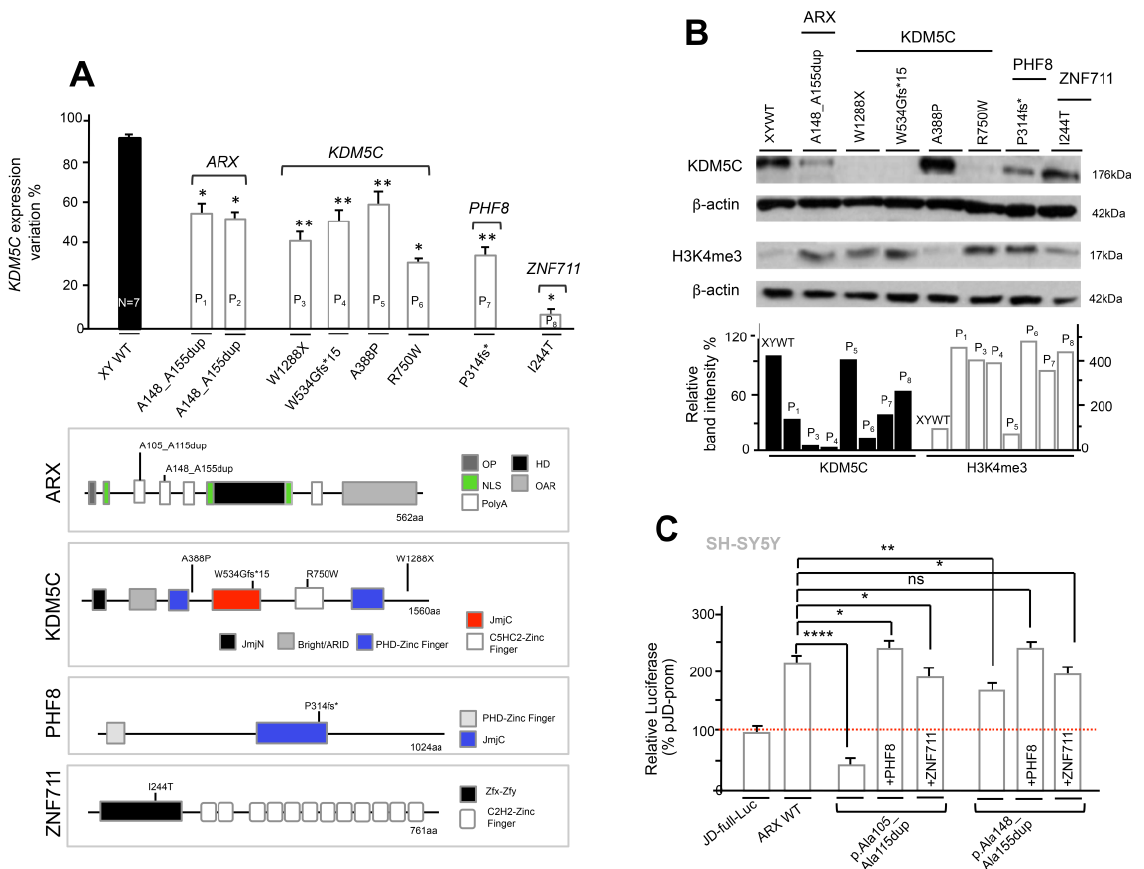
Figure 6. KDM5C defects associated to NDD mutations. KDM5C expression in lymphoblastoid cell lines obtained from distinct NDD patients mutated in ARX, KDM5C, PHF8 , and ZNF711. The percentages indicate the expression variation with respect to the WT, which has a mean of seven ( n = 7) different cell lines from male age-matched males. The transcript analysis was performed in triplicate and the samples were normalized to 18S . The bars indicate the mean ± standard error of three independent experiments ( top panel ). Positions of the studied mutations are shown in the cartoon ( bottom panel ). OP, Octapeptide; polyA, polyalanine tracts; NLS, Nuclear localization sequences; HD, homeodomain; OAR, Aristaless domain; JmN, jumonji-N domain; ARID, AT-rich interacting domain; PHD, plant homeodomain box domain; JmjC, jumonji-C catalytic domain; ZF, zinc finger domain; PLU-1, PLU-1-like domain; Zfx/Zfy, Transcription activation domain ( A ). Western blotting for KDM5C and its substrate H3K4me3 was performed on cellular extracts from LCLs. The β -actin antibody ( β -actin) was used as a loading control. Each experiment was repeated with two independent LCL protein extracts with similar results ( B ). Effects of PHF8 and ZNF711 overexpression on KDM5C 5 (cid:48) UTR region in cotransfection with ARX polyalanine elongated mutants. Each luciferase assay was performed in duplicate in four independent experiments. The bars indicate the mean ± standard error of four independent experiments ( C ). * p < 0.05; ** p < 0.005; **** p < 0.0005; ns, not